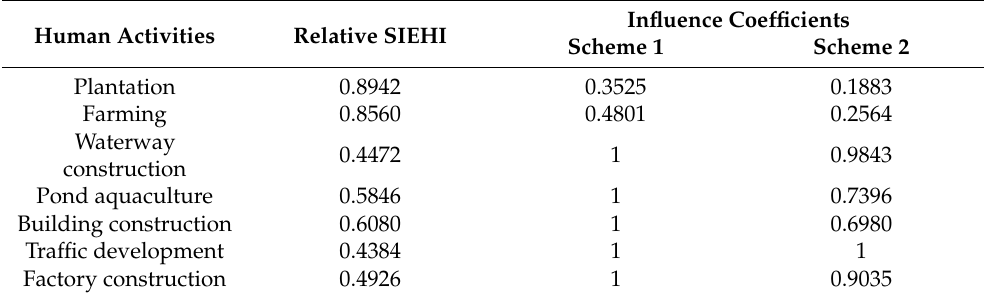
Table 7. Influence coefficients of different types of human activities on the sandy island